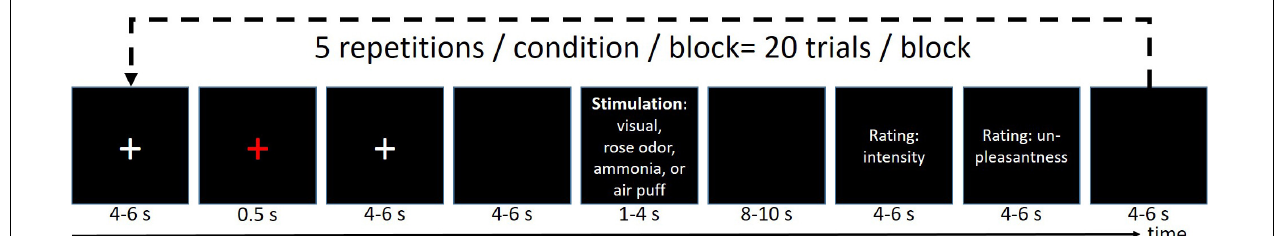
FIGURE 1 | Experimental design. Each run was repeated three times resulting in 15 stimuli/condition/participant.